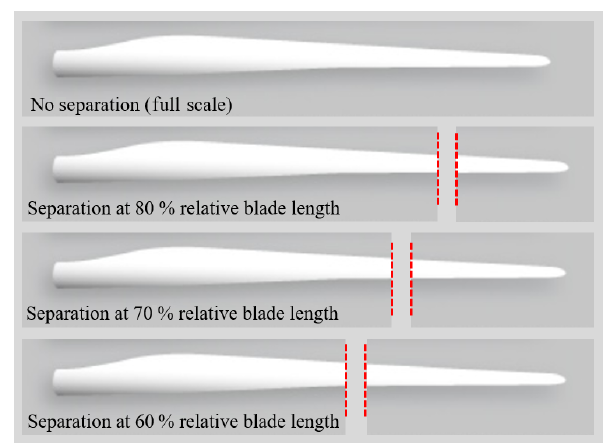
Figure 1. Schematic representation of a blade with different sepa- ration